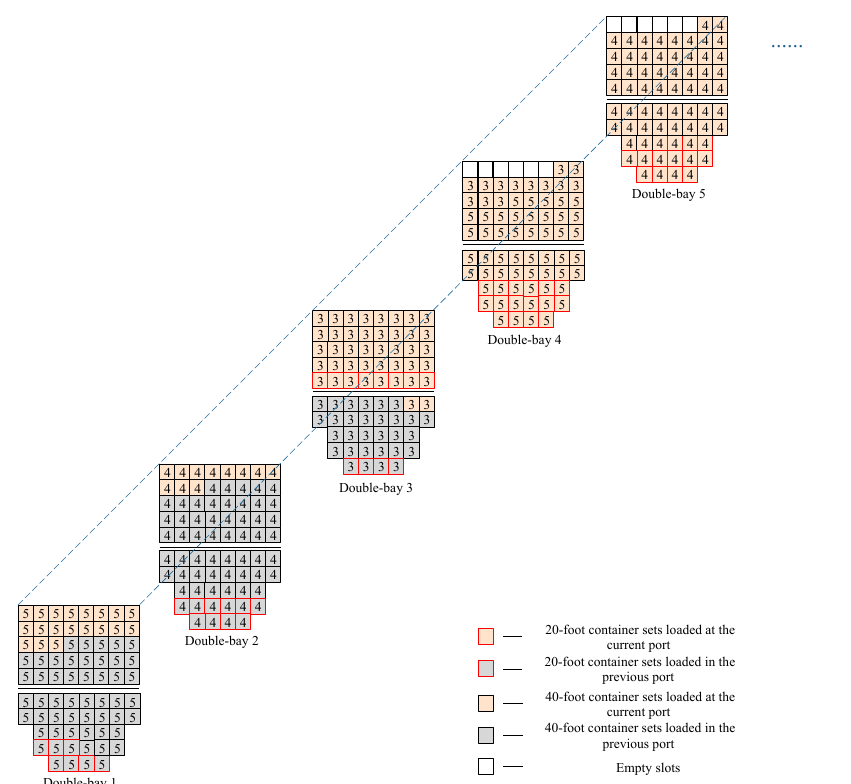
Figure 8. Stowage results in port 2 with rule